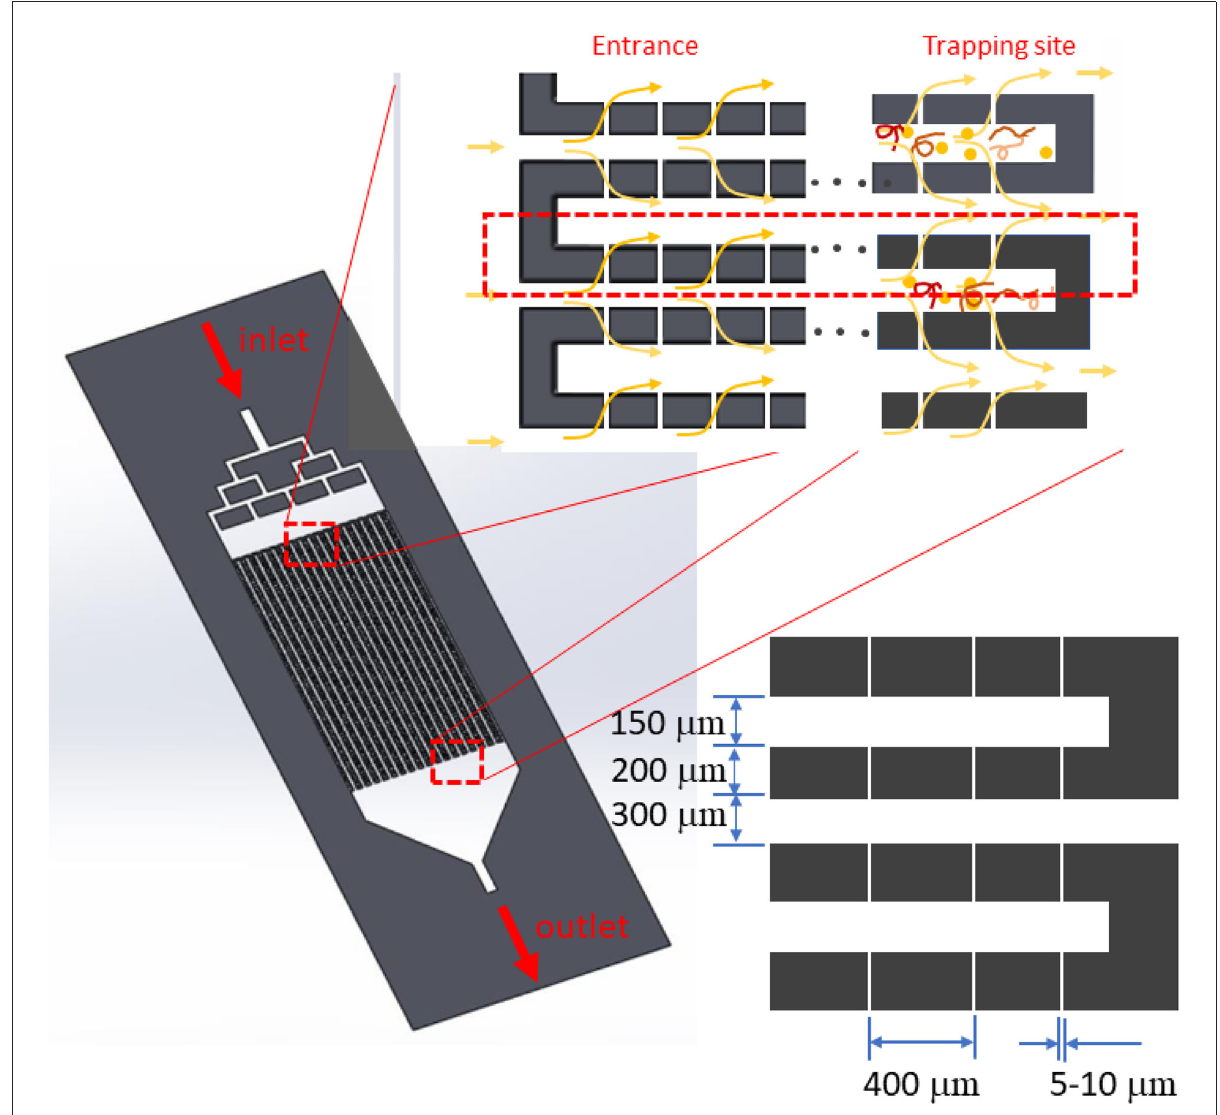
FIGURE1 System design with long flow passages. Between the inlet and outlet passage, 5- µ m micro-capillaries are placed on both the right- and left-hand walls. Microfilariae are captured at the end of each inlet flow